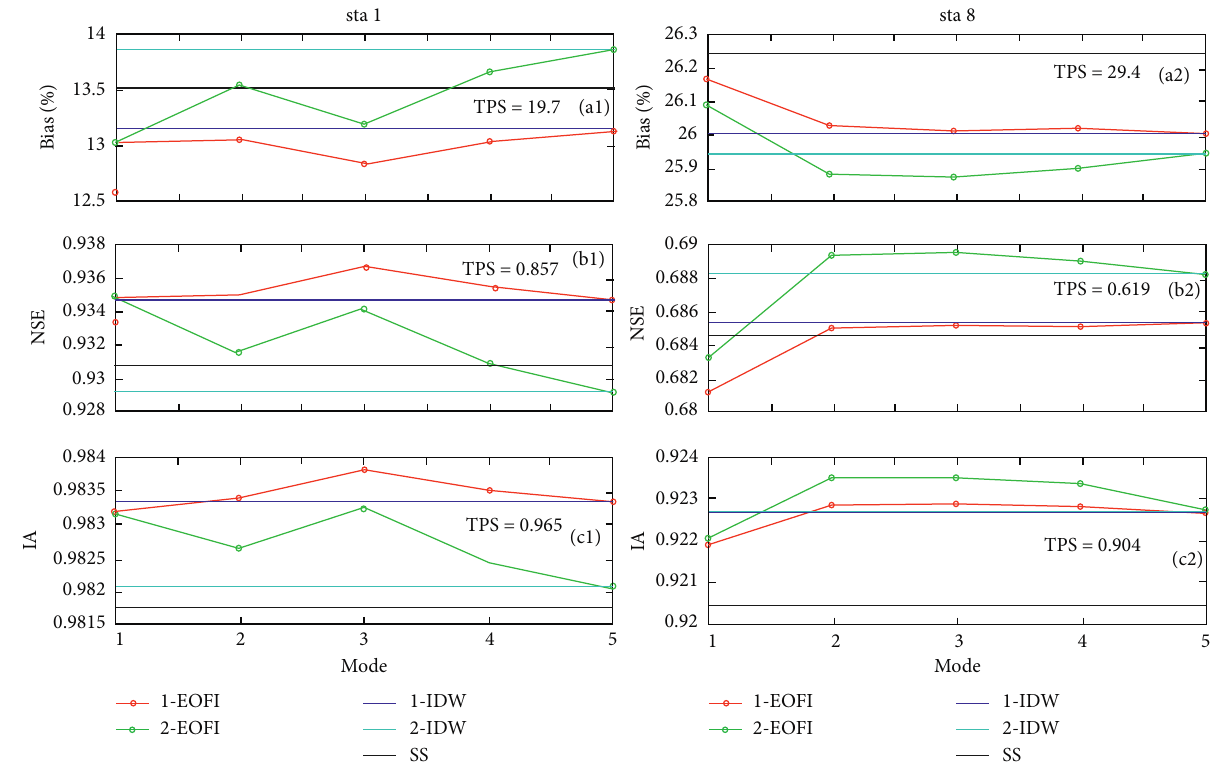
Figure 7: Same as Figure 6, but the indices are bias, NSE, and IA in sta 1 and sta 8. Table 3: RMSE between the results of EOFI reconstruction and the valid observation records of 4 and 5 stations selected by sta 1 and sta 8,